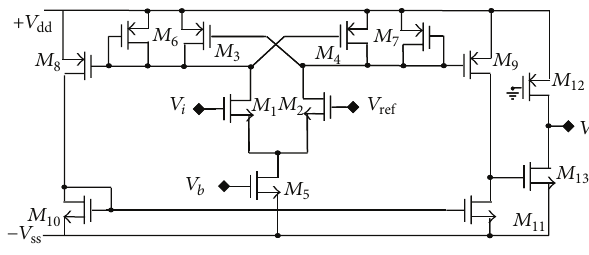
Figure 3: Schematic of comparator.